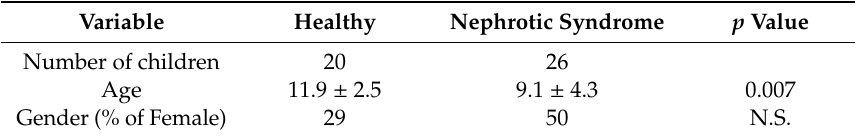
Table 1. Demographic characteristics of children with nephrotic syndrome and a control group of healthy children.